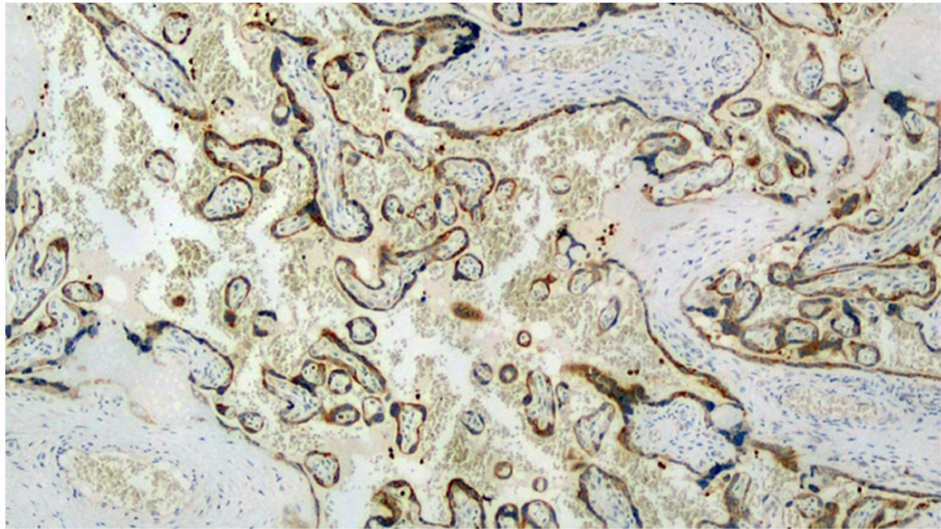
Figure 2. Immunostaining for anti-SARS-CoV-2 spike protein S1 positive at the level of the syncy-